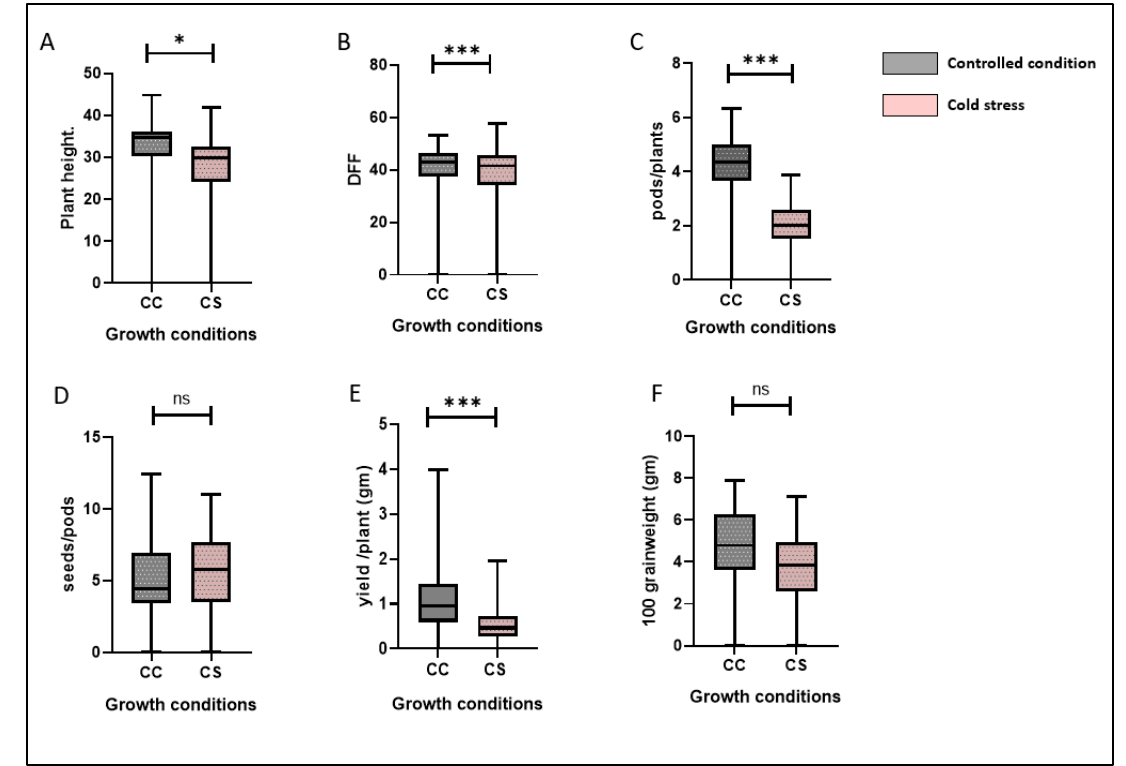
Figure 2. Effect of CS germination on growth at vegetative, reproductive stages and yield parameters. ( A ) Plant height (PH), ( B ) Days to 50% flowering (DFF), ( C ) Pods/plant, ( D ) Seeds/pods, ( E ) Yield/plant and ( F ) 100 Grain weight. Seeds were germinated either at 22 °C or 10 °C for8 days after sowing, followed by growth at natural day-night conditions for 25 – 30 days. Data phenotyped at 25 – 30 DAS of vegetative stage, 56 – 75 DAS of reproductive stage, and post-harvest from 15 plants in 3 biological replicates. Data represents the median with mean indicated by line in the boxes. Significance was conducted using unpaired t -test and is indicated as * is p < 0.05; ***, p < 0.005.